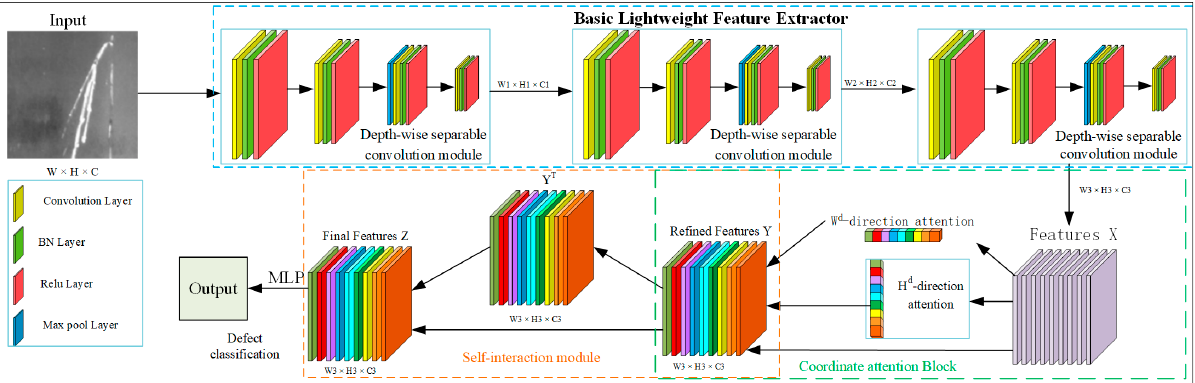
Figure 7. [85] Overview of the CASI-Net framework. Figure 7. Overview of the CASI-Net framework